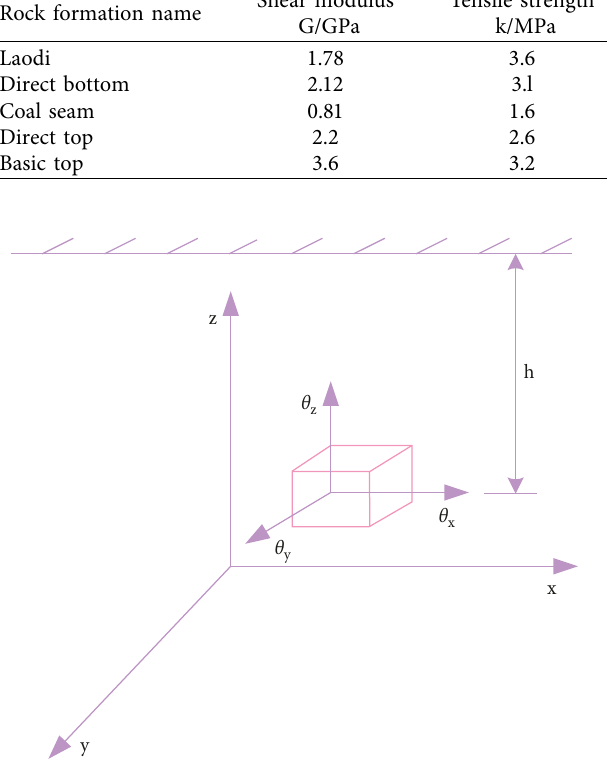
Figure 1: Gravity vertical stress of the rock